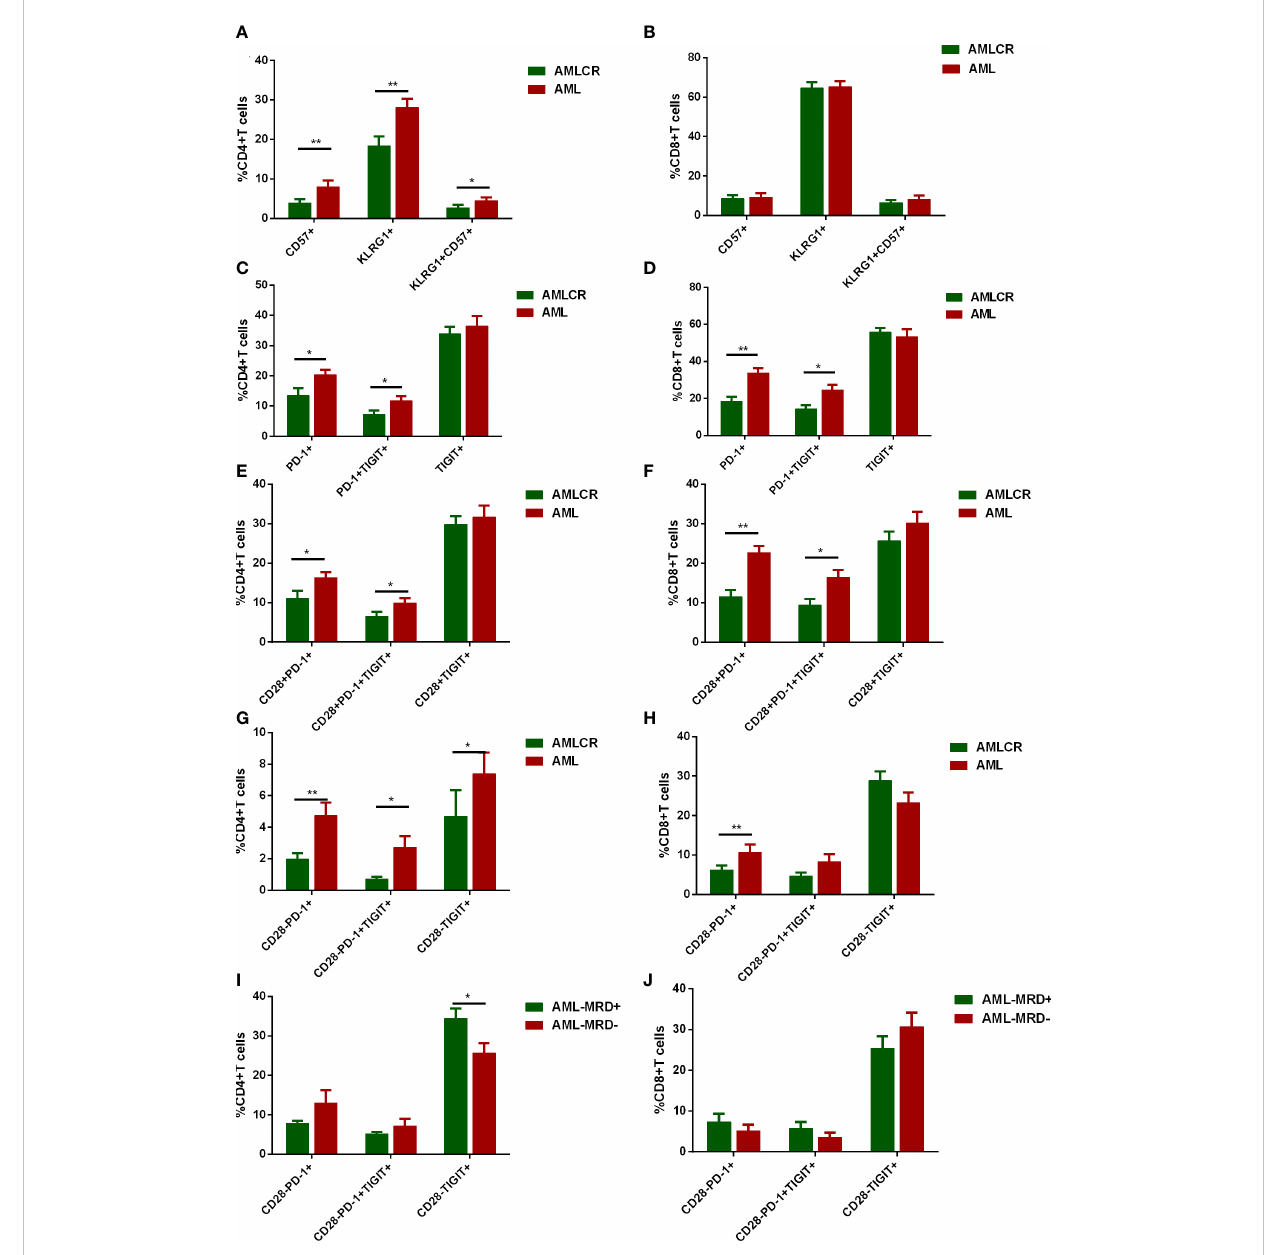
FIGURE 5 Dynamic alteration of senescent T cells and T cell exhaustion in different disease status of AML. CD57 and KLRG-1 expression of CD4 + T cells (A) and CD8 + T cells (B) were evaluated in de novo AML patients (n=42) and AML patients in complete remission (AML-CR, n=32). In addition, the percentages of PD-1 + , TIGIT + and PD-1 + TIGIT + subsets of CD4 + (C) and CD8 + (D) T cells in BM of de novo AML patients and AML-CR were compared. Further analyses of PD-1 and TIGIT expression on CD28 + CD4 + (E) and CD28 + CD8 + (F) T cells in BM of de novo AML patients and AML- CR were performed. Similarly, PD-1 and TIGIT expression on CD28 - CD4 + (G) and CD28 +_ CD8 + (H) T cells in BM of de novo AML patients and AML- CR were compared. At last, the expression of PD-1 and TIGIT in CD28 - subsets of CD4 + (I) and CD8 + (J) T cells were analyzed in AML-CR patients with minimal residual disease (MRD) (n=12) and without MRD (n=20). Student ’ s t test or Mann-Whitney U test was used to analyze the data according to normal distribution of data. *, ** indicated p-values between 0.01 to 0.05, 0.001 to 0.01